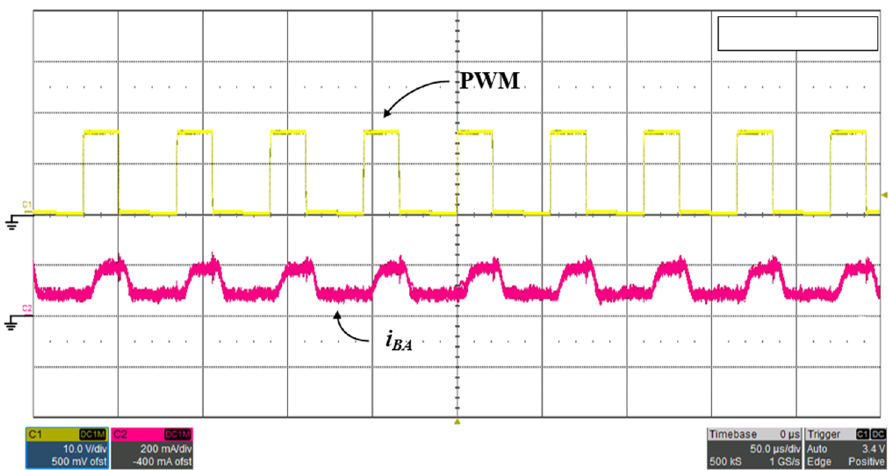
Figure 17. Experiment results in normal state.